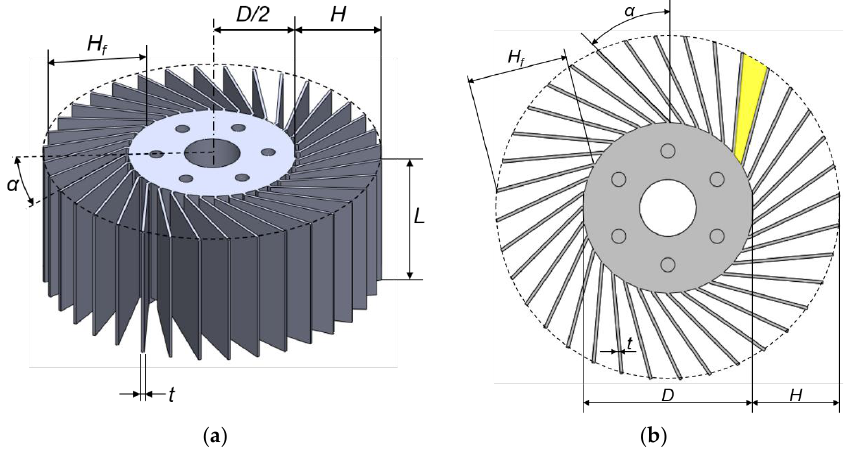
Figure 2. Cylindrical heat sink with inclined plate fins. ( a ) schematic diagram; ( b ) top view.